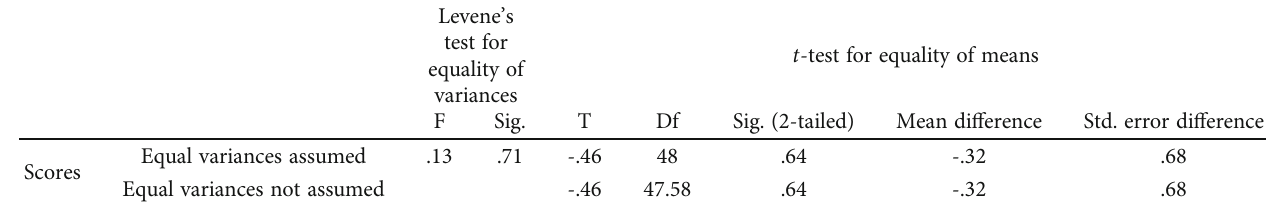
Table 2: Inferential statistics of the idiom pretests.